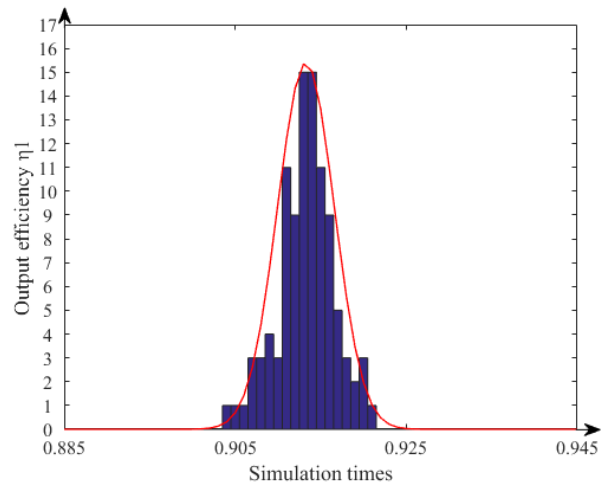
Figure 19. The distribution of the functional requirement value of collecting TCM.